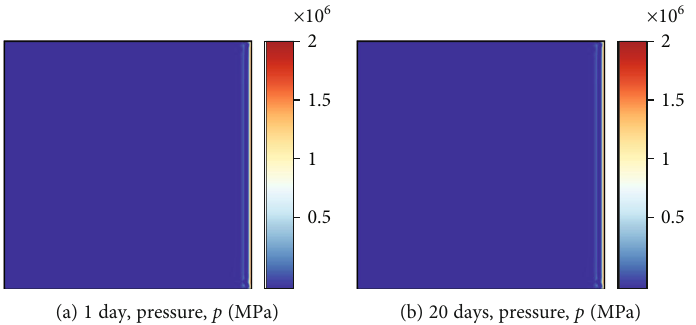
Figure 4: The distributions of gas pressure at t = 1 and 20 days.